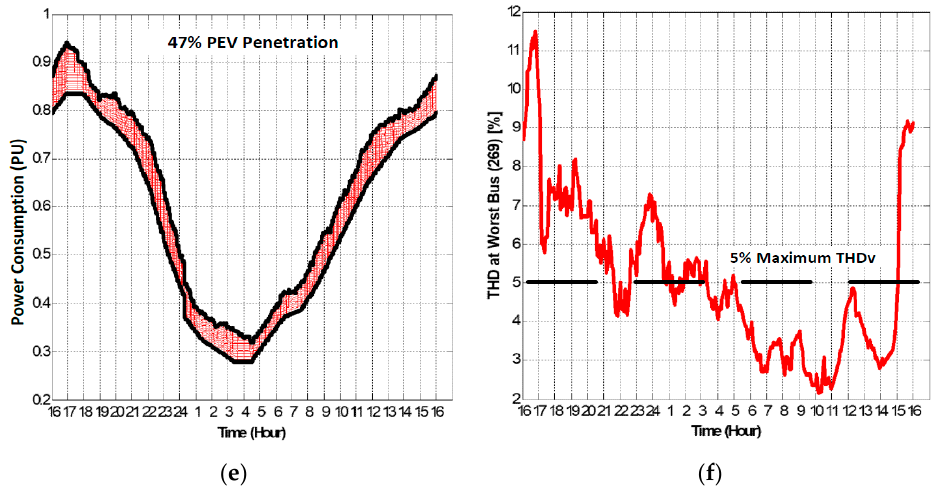
Figure 5. Simulation results for Case 1—Uncoordinated PEV charging considering harmonics including power consumption and THDv of ( a , b ) 16% PEV charging penetration; ( c , d ) 32% PEV charging penetration; ( e , f ) 47% PEV charging penetration.